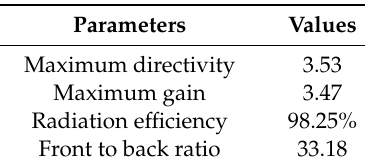
Table 2. Simulated results for the proposed antenna sensor main parameters.